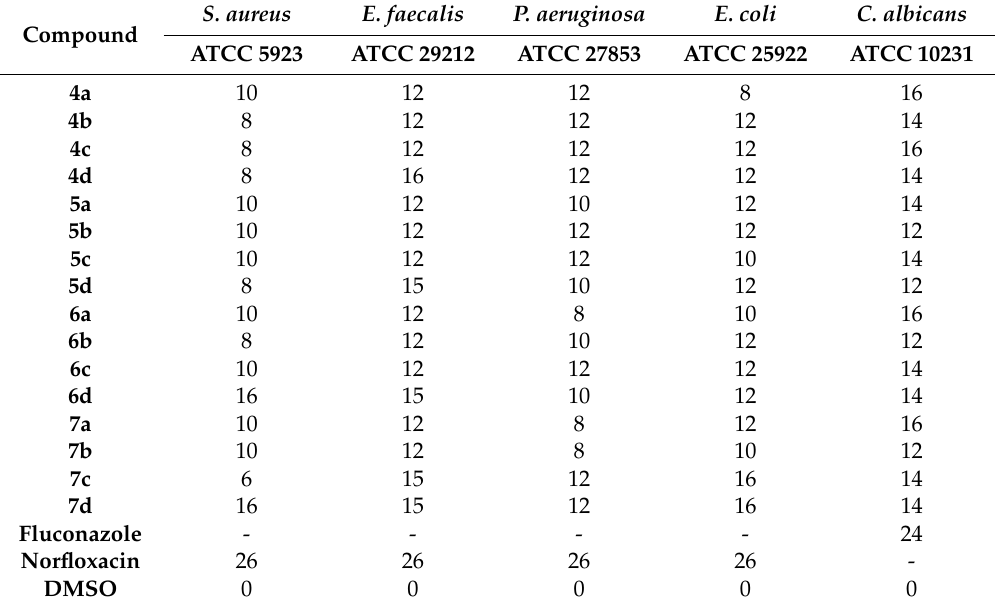
Table 1. The antimicrobial activity of the tested compounds expressed as zone diameters of microbial growth inhibition